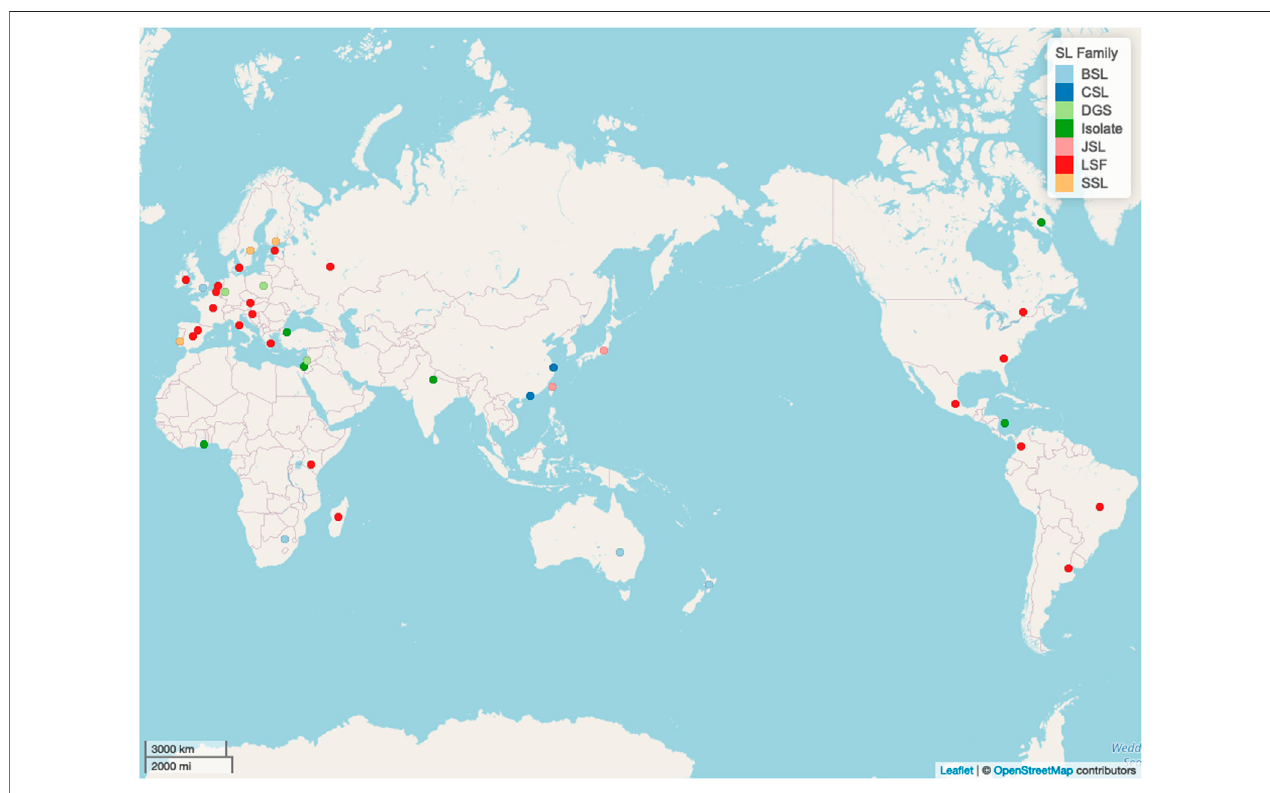
FIGURE 1 | Map of signed languages by family af fi liation in the sample.